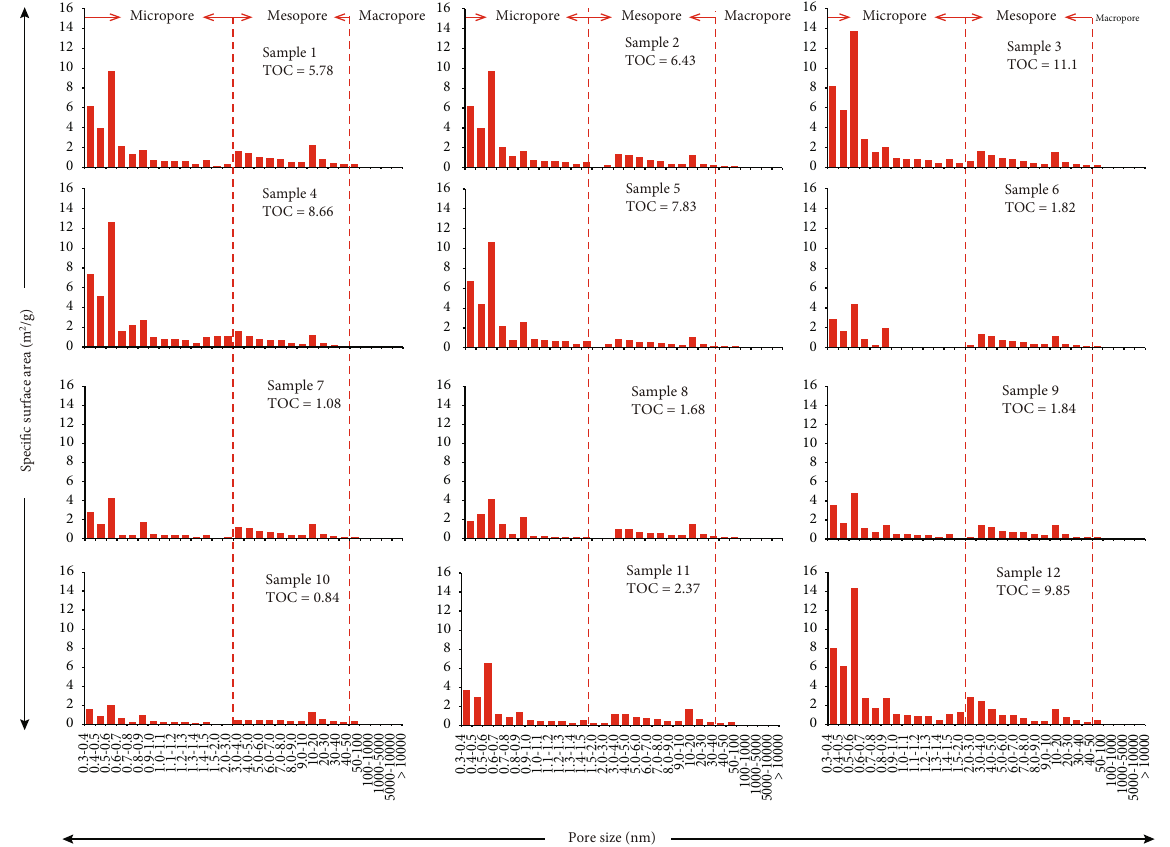
Figure 7: Histogram of complete SSA distribution of shale samples. Table 4: Statistical results of speci fi c surface area of shale